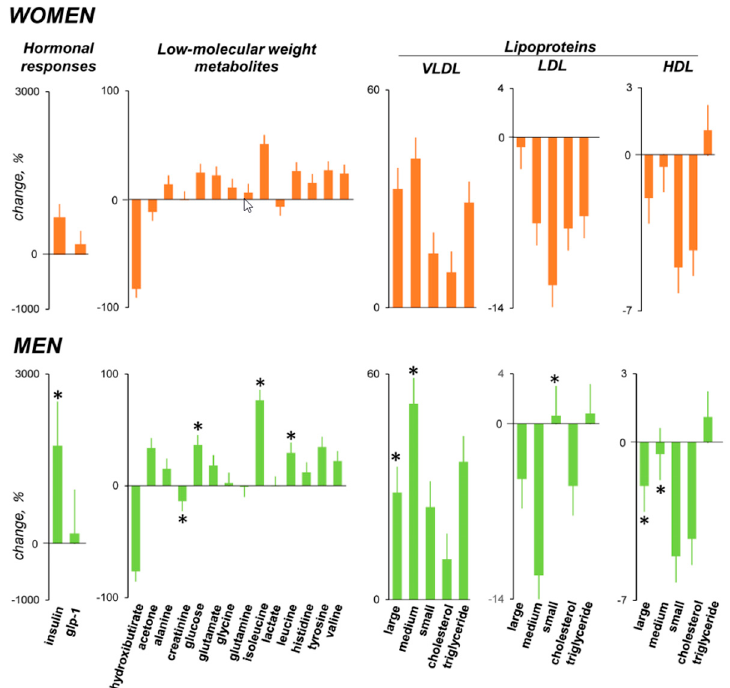
Figure 5. Metabolomic response to the meal. Data are changes from basal. Note, a more pronounced response in men than in women (* p < 0.05 men vs. women), possibly related to their larger meal